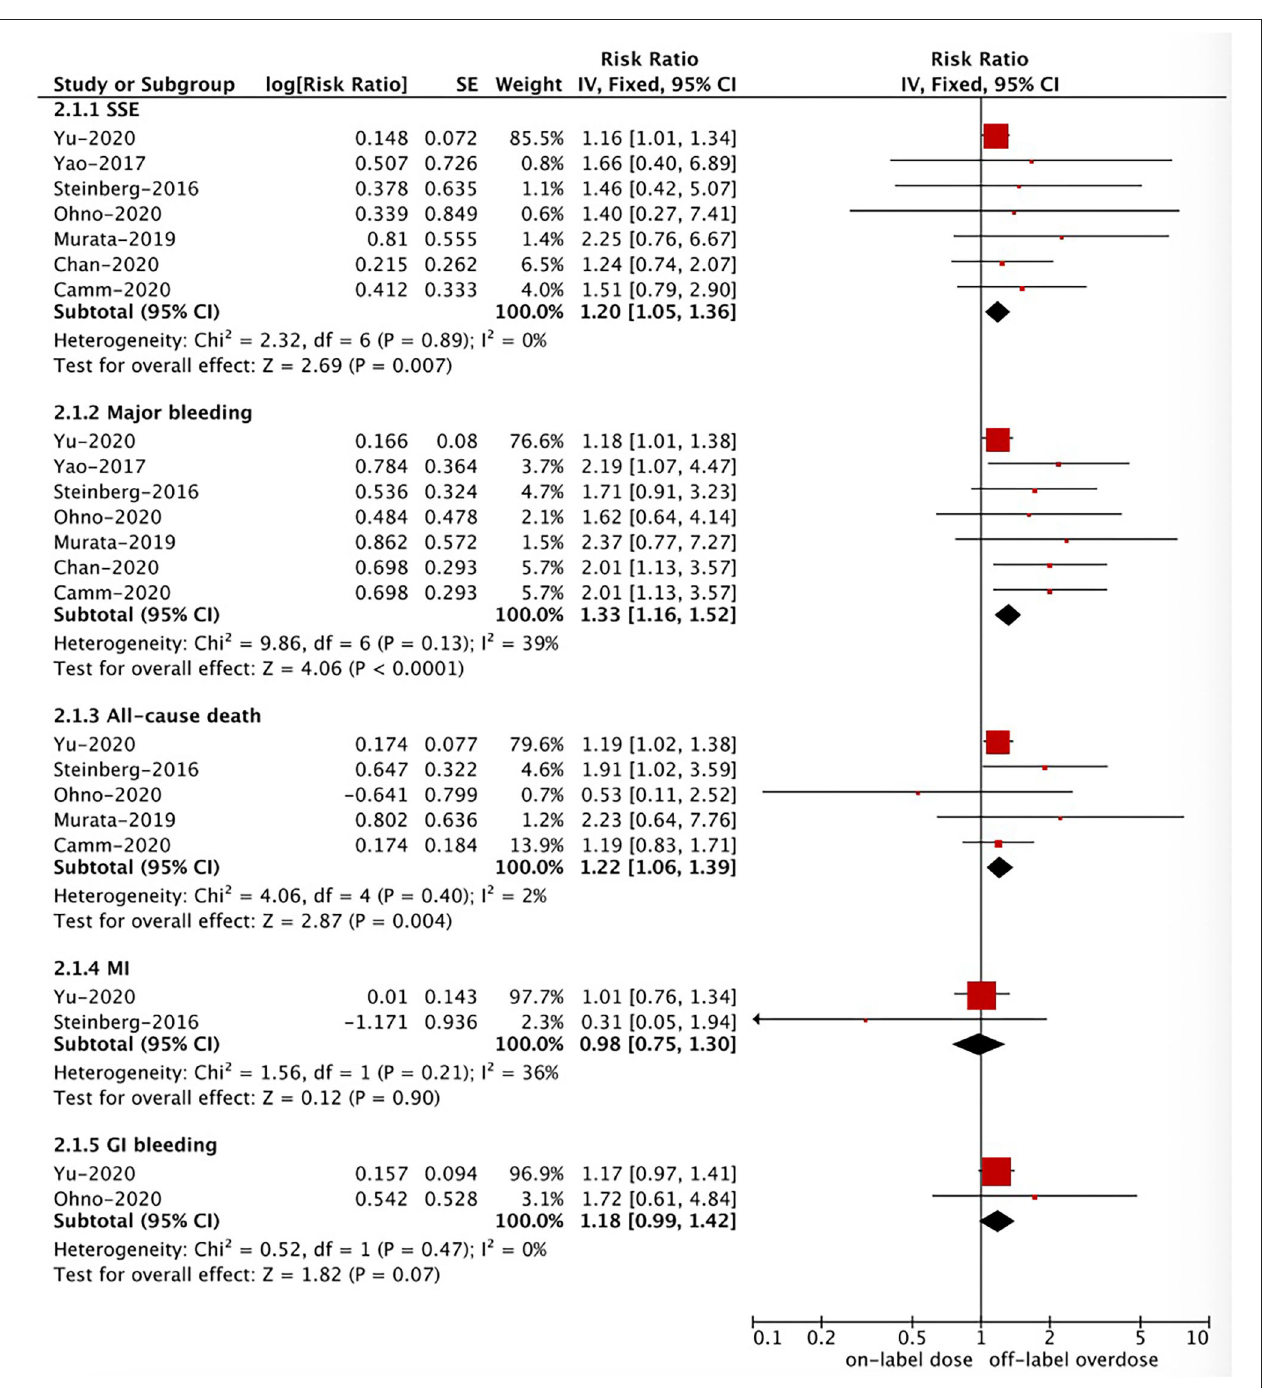
FIGURE 4 | A fixed-effects model for comparing the ischemic stroke between off-label overdose and on-label dose of NOACs in patients with atrial fibrillation NOACs, non-vitamin K antagonist oral anticoagulants; SSE, stroke or systemic embolism; MI, myocardial infarction; CI, confidence interval; SE, standard error; IV, inverse of the